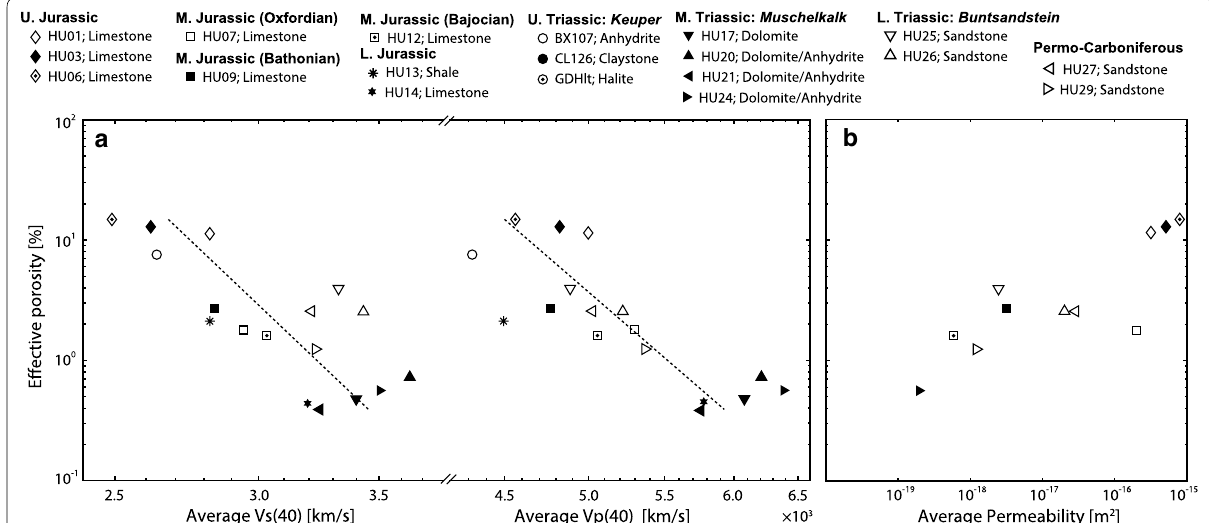
Fig. 12 Cross-plot is showing the relationship between the average seismic velocity and the effective porosity. The values of the seismic velocities were calculated at 40 MPa confining pressure using the empirical formula of Wepfer and Christensen (1991). A clear negative trend confirms the general observation that the seismic velocity decreases with increasing effective porosity. The significant dispersion in the velocity-porosity relationship, particularly for the shear velocity, can be related to other controlling factors such as the mineralogy, grain size, grain shape and pore geometry. Error bars are within symbols